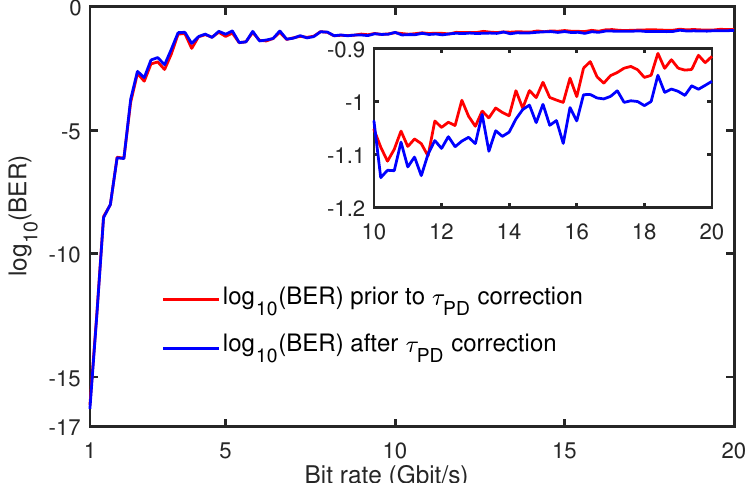
Figure 13. Estimation of BER values of the recovered messages for different bit rates at modulation depth b = 0.2. Red and blue traces correspond to BER value prior to and after the τ PD correction, respectively, in the receiver